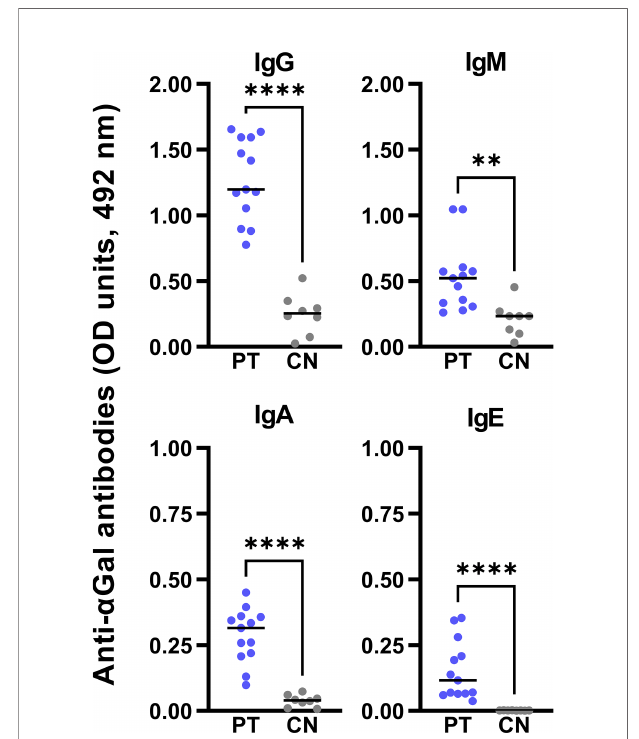
FIGURE 4 | Serological levels of anti- a Gal antibodies by ELISA. a Gal- sensitized patients (PT, n=13, blue dots) showed signi fi cantly higher serological anti- a Gal antibodies levels (expressed as optical density units, 492 nm) compared to healthy subjects (CN, n=8, grey dots). To detect each immunoglobulin isotype, serum samples were accordingly diluted: 1:100 for IgM and IgG, 1:25 for IgA, and 1:10 for IgE. Unpaired t-test analysis was performed (**: p < 0.01; ****: p <